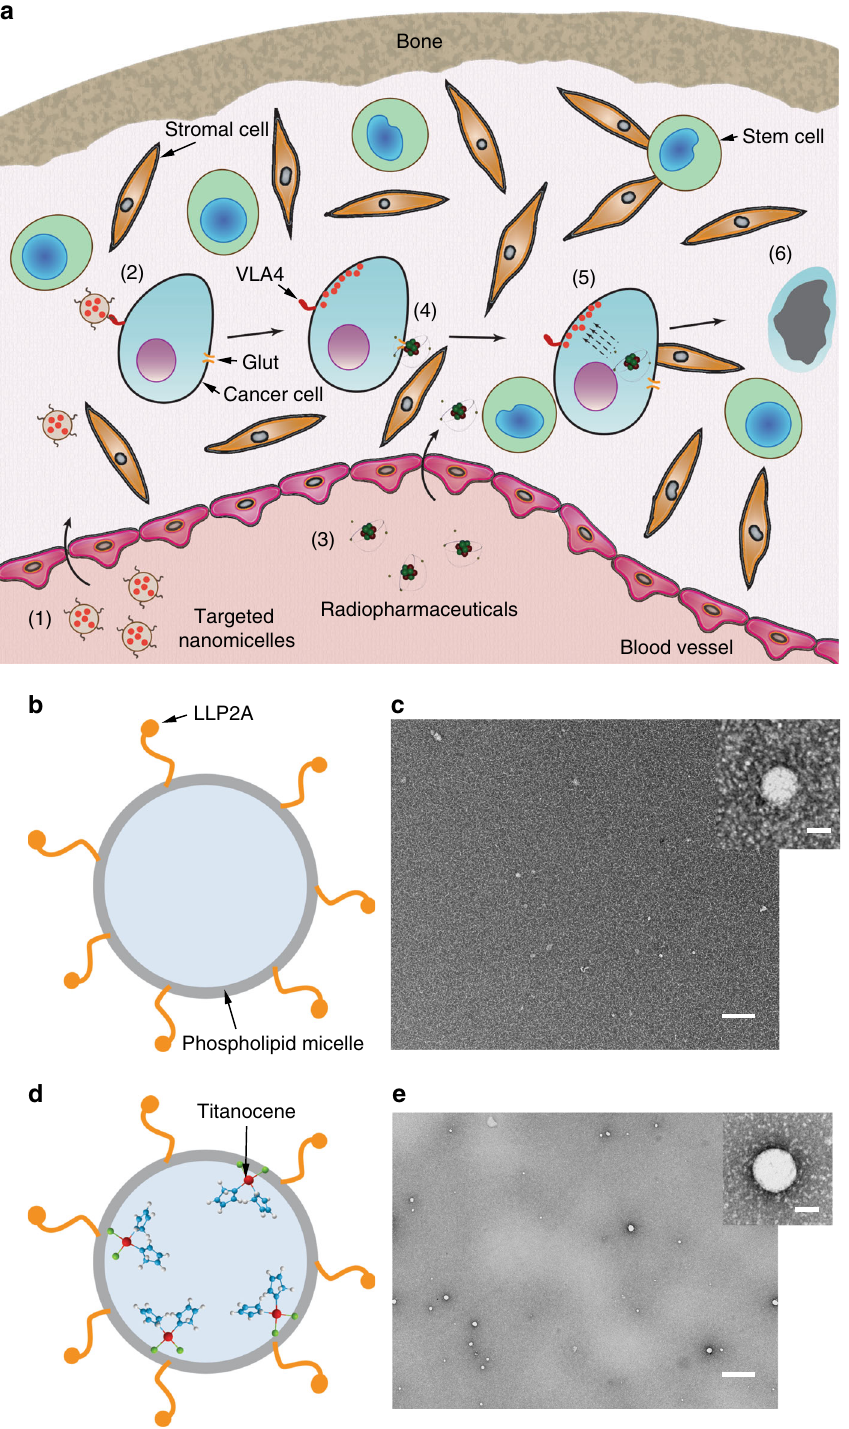
Fig. 1 Orthogonal cancer targeting strategy using nanomicelles. a Schematic of the process of photoactivation of Titanocene in disseminated cancer cells in the bone marrow microenvironment. The various phases are numbered: 1. Administration of targeted NM-TC; 2. The targeted NM enter the bone marrow from the vasculature and bind to α 4 β 1 receptor on the cancer cells and subsequently deliver the drug to the cell; 3. Administration of radiopharmaceuticals ( 18 FDG), which is typically 1.5 – 2 h after phase (1); 4. 18 FDG enters the cancer cells through the overexpressed Glut transporters on cancer cells; 5. Once the drug and radiopharmaceutical are co-localized in the cancer cells, the former is photoactivated by the latter through CR leading to cell death (6). Notice that since the other vital cells in the bone marrow, such as stem cells and stromal cells, do not express the combination of α 4 β 1 and glut receptors essential for the treatment to work, they would largely remain unaffected causing minimal off-target toxicity. b Schematic of phospholipid NM with VLA-4 homing ligands. c TEM image of micelles alone. Scale bar, 100 nm. Inset: single micelle. Scale bar, 10 nm. d Schematic of phospholipid NM encapsulating TC with VLA-4 homing ligands. e TEM image of micelle incorporated with TC in the membrane. Scale bar, 100 nm. Inset: single NM-TC. Scale bar, 10